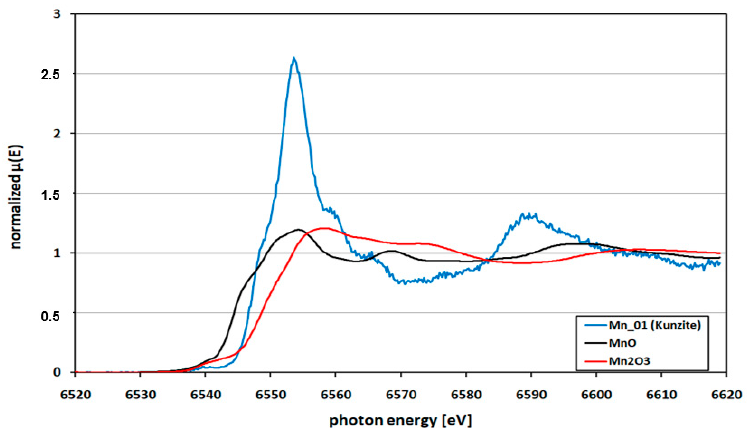
Figure 4. Mn K-edge XANES spectrum of kunzite from Nuristan, Afghanistan, (Mn-01, represents kunzite sample K-01) versus MnO and Mn 2 O 3 standards. The edge position of the kunzite is just between the MnO and Mn 2 O 3 .